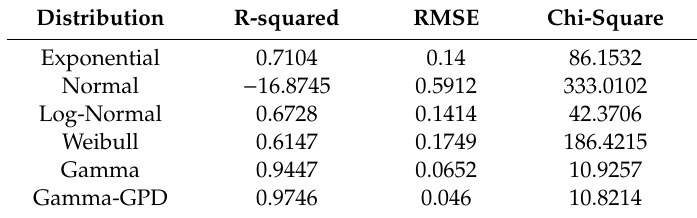
Table 3. The goodness of fit of various models under current conditions (drought intensity).